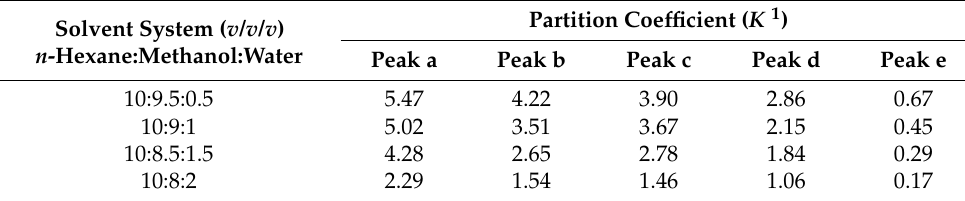
Table 1. The K values of major peaks a – e in n -hexane extract in different solvent systems. Solvent System ( v / v / v )